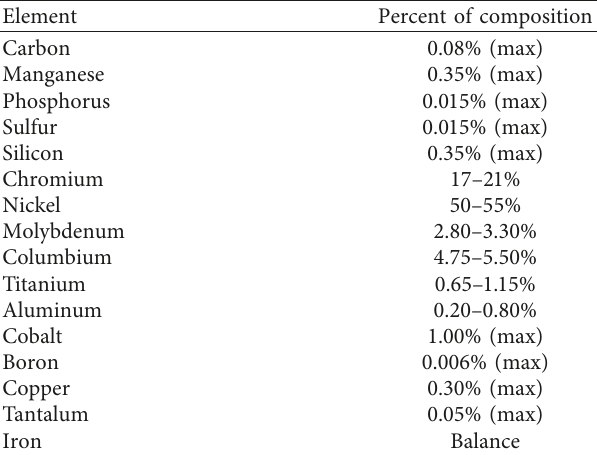
Table 2: Inconel 718 chemical